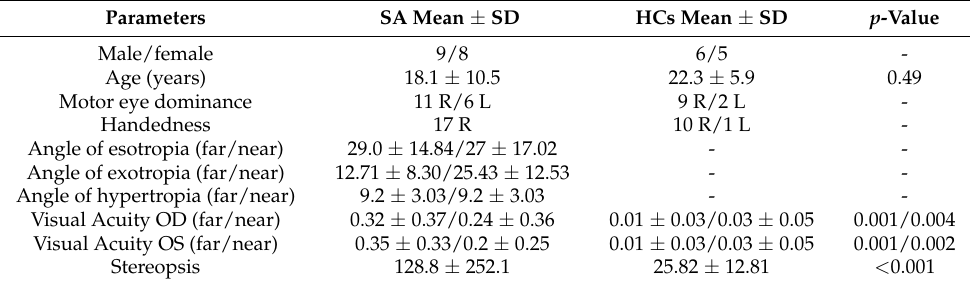
Table 1. Demographics and clinical measurements at baseline of SA and HC